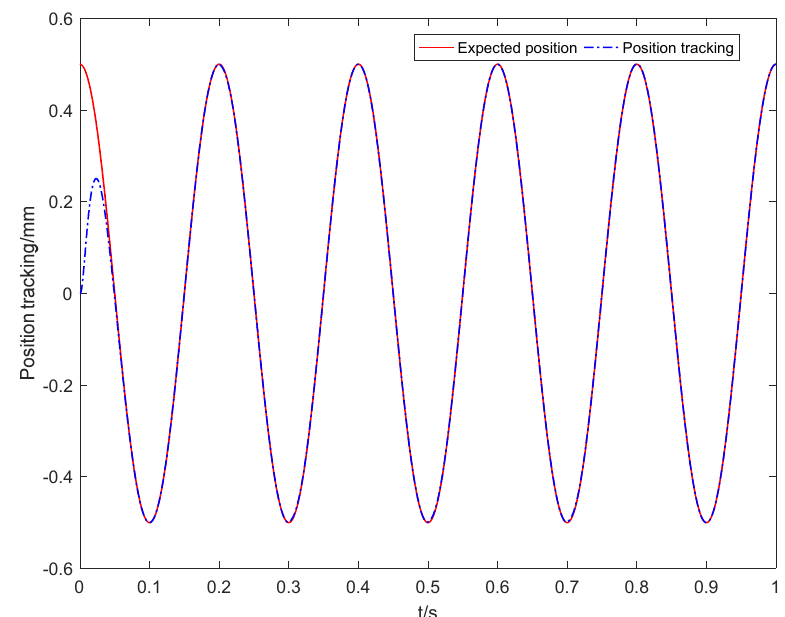
Figure 7. Position tracking curve under dynamic signal.